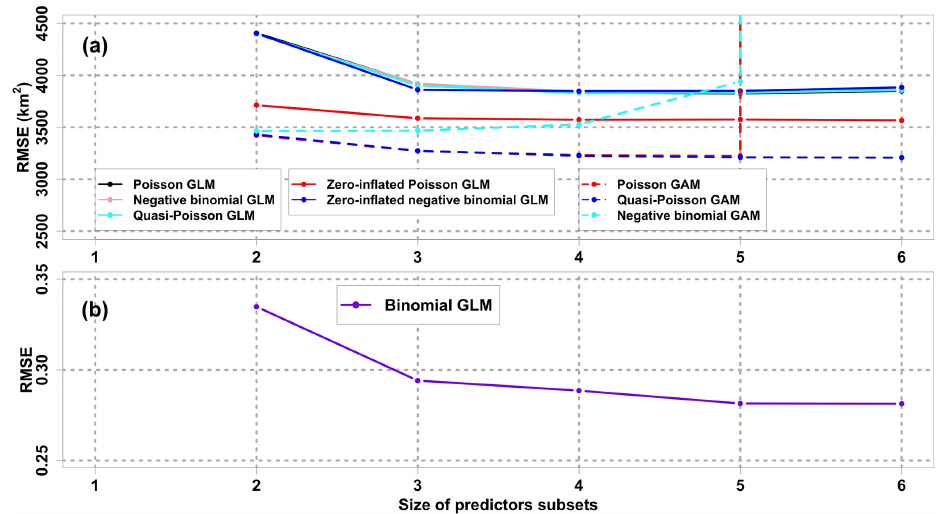
Figure 3. Comparisons of mean 10-fold CV RMSEs among different regression models with various sizes of predictors subsets. The response variable in (b) binomial GLM and (a) other models is hypoxia occurrence (hypoxia) and hypoxic area (HA), respectively. Note that the CV RMSEs of negative binomial GAM and Poisson GAM with the size of 6 are out of the range shown. CV RMSE curves of the Poisson GLM, negative binomial GLM, and quasi-Poisson GLM overlap, while those of Poisson GAM and quasi-Poisson GAM overlap when the size ≤ 5. The minimum size of predictor subsets is 2, since PEA and SOCalt are forced into every subset.